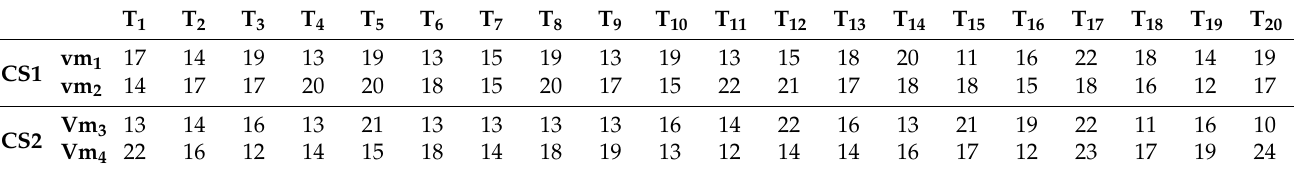
Table 4. Corresponding computational